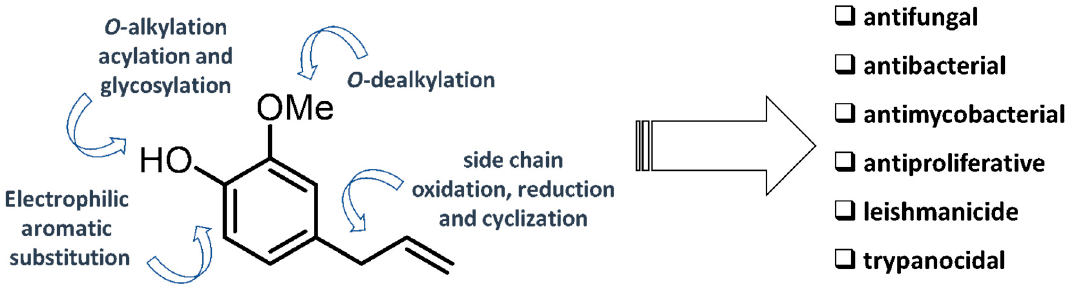
Figure 1. Structural changes in eugenol leading to new bioactive Figure 54. Structural changes in eugenol leading to new bioactive compounds.